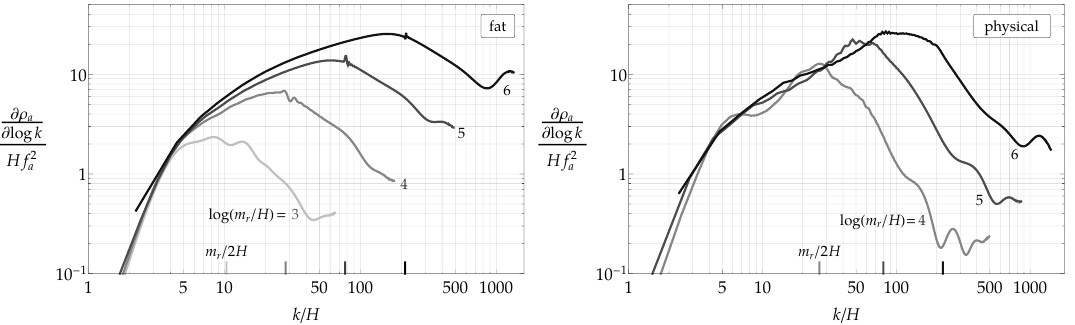
Figure 27 . The axion energy density spectrum @(cid:26) a =@ log k for the fat string (left) and the physical (right) cases (the data is the same as in (cid:12)gure 10 but represented on a log scale).